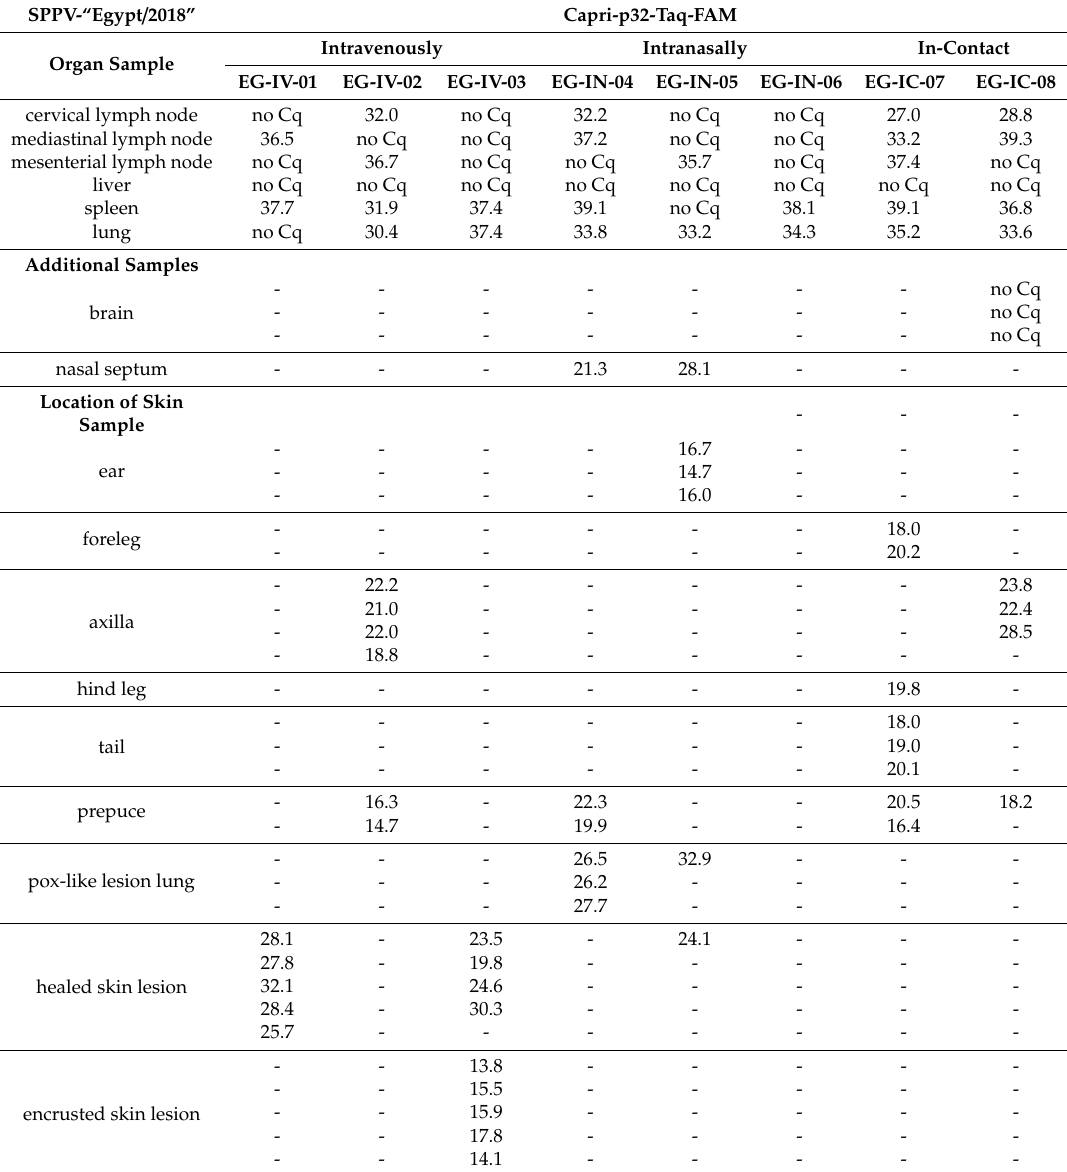
Table 5. Viral genome load (Cq-values) of di ff erent organ samples taken during necropsy after experimental infection of sheep with SPPV-“Egypt /